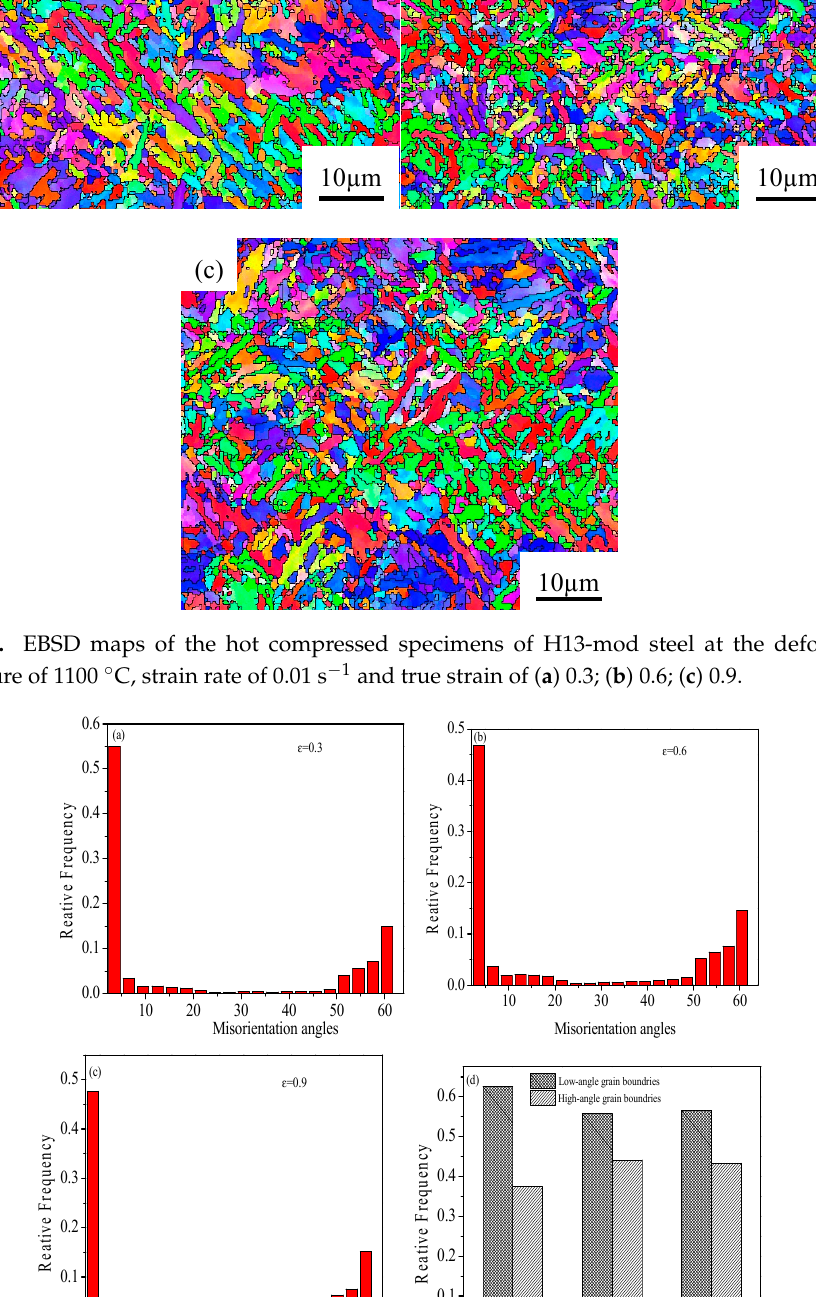
Figure 12. Grain orientation image of H13-mod steel at the deformation temperature of 1100 °C, strain rate of 0.01 s − 1 and true strain of ( a ) 0.3; ( b ) 0.6; ( c ) 0.9; and ( d ) grain boundary distribution under different deformations.